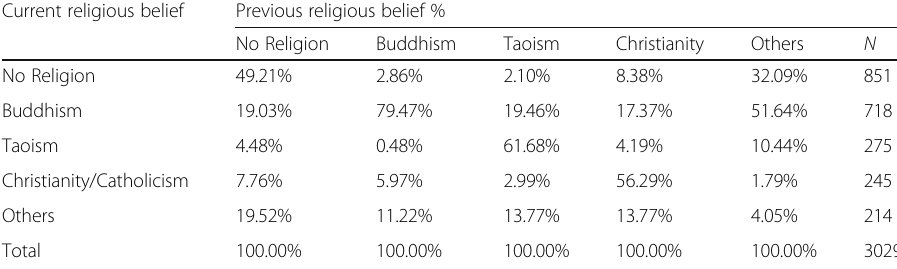
Table 5 Religious belief switch pattern Current religious